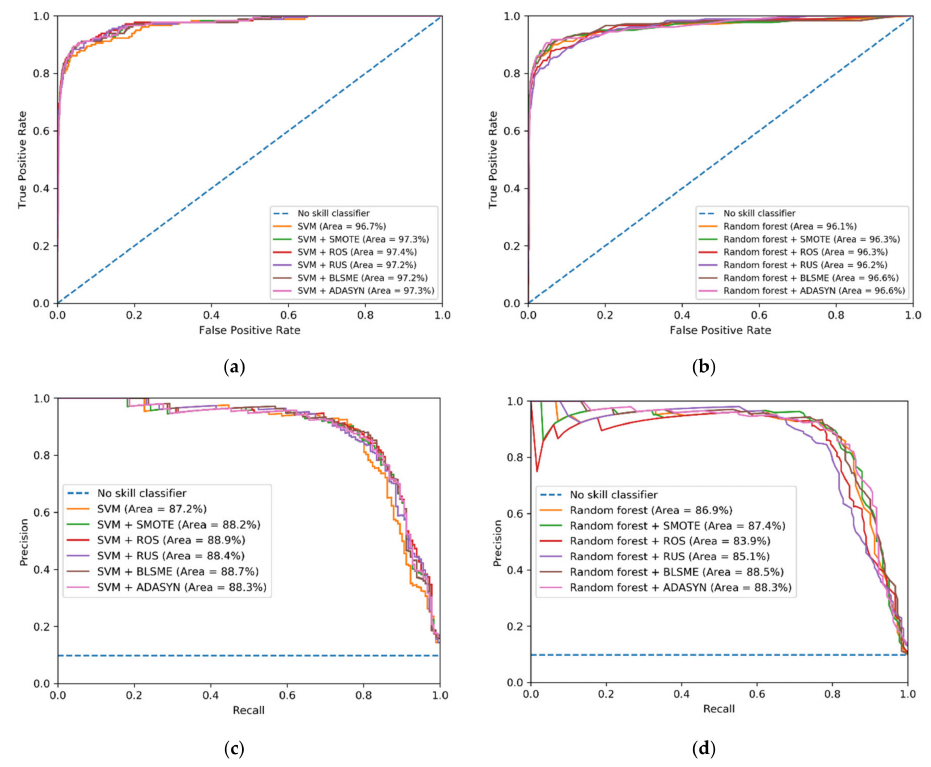
Figure A8. The ROC and PR curves of SVM and Random Forest for Fold 7; ( a ) the ROC curve of SVM; ( b ) the ROC curve of Random Forest; ( c ) the PR curve of SVM; and, ( d ) the PR curve of Random Forest.